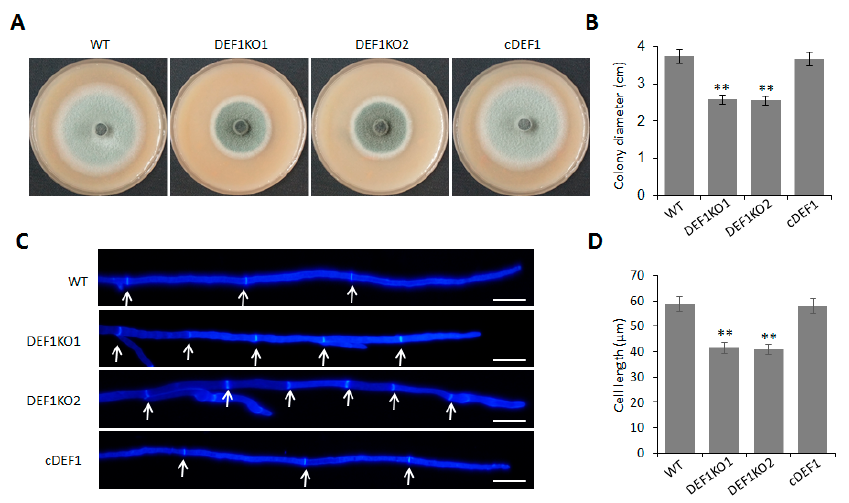
Figure 2. Deletion of Def1 affects colony growth in M. oryzae . ( A ) The colony of different strains grown on OTA plates at 28 ◦ C for 5 days. ( B ) Colony diameters of different strains. Significant differences are labelled with asterisks (**, p < 0.01). ( C ) Hypha tips of different strains stained by CFW. Cell septa are indicated with arrows. Bar = 20 µ m. ( D ) The length of hypha apical cells of different strains. Significant differences are labelled with asterisks (**, p < 0.01). WT, wild type; DEF1KO1 and DEF1KO2, two independent def1 knock out mutants; cDEF1, complementary strains.